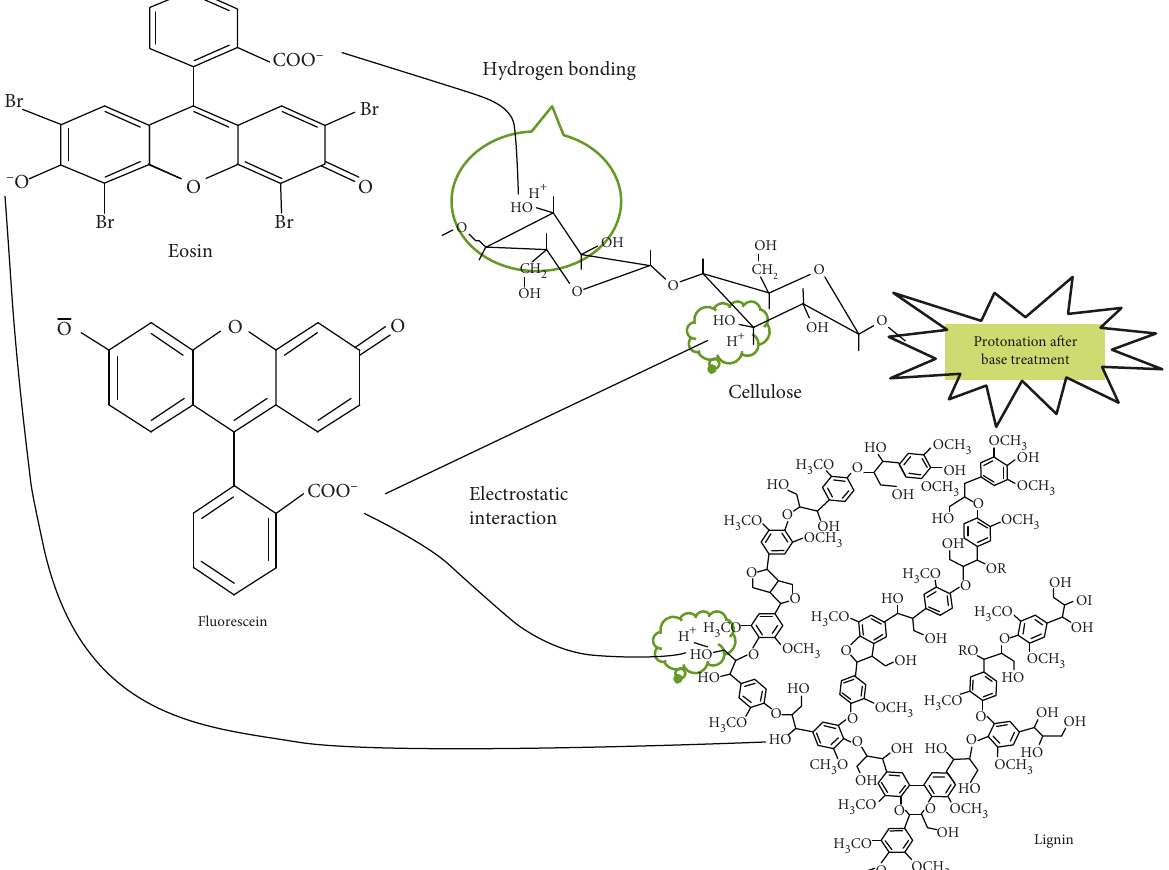
Figure 9: Interaction of acidic dyes with the lingocellulosic material of Citrullus lanatus